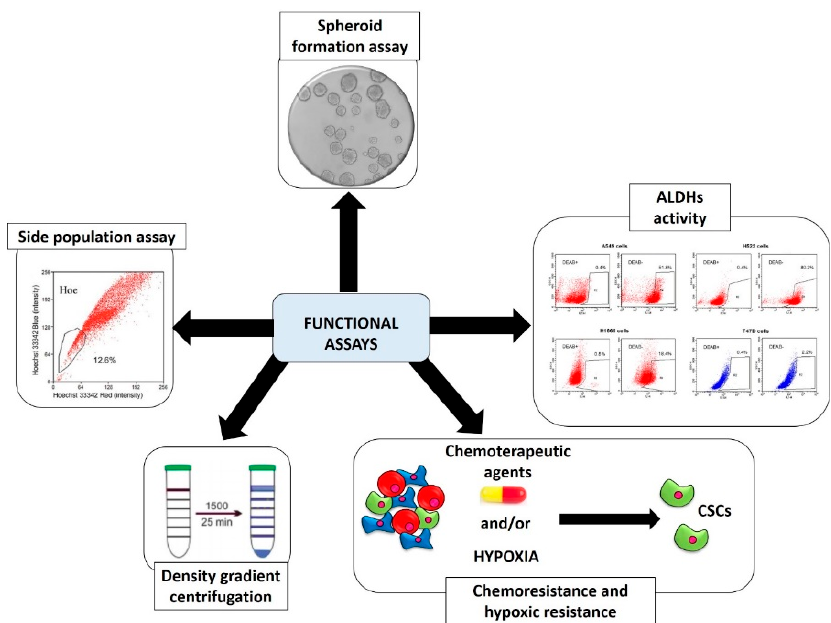
Figure 2. The most used functional assays for the identification, isolation and enrichment of cancer stem cells. CSCs: cancer stem cells. The most used functional assays for identification, isolation and enrichment of CSCs are spheroid formation assay, ALDHs activity, selection for chemo and/or hypoxic resistance, density gradient centrifugation and side population assay.